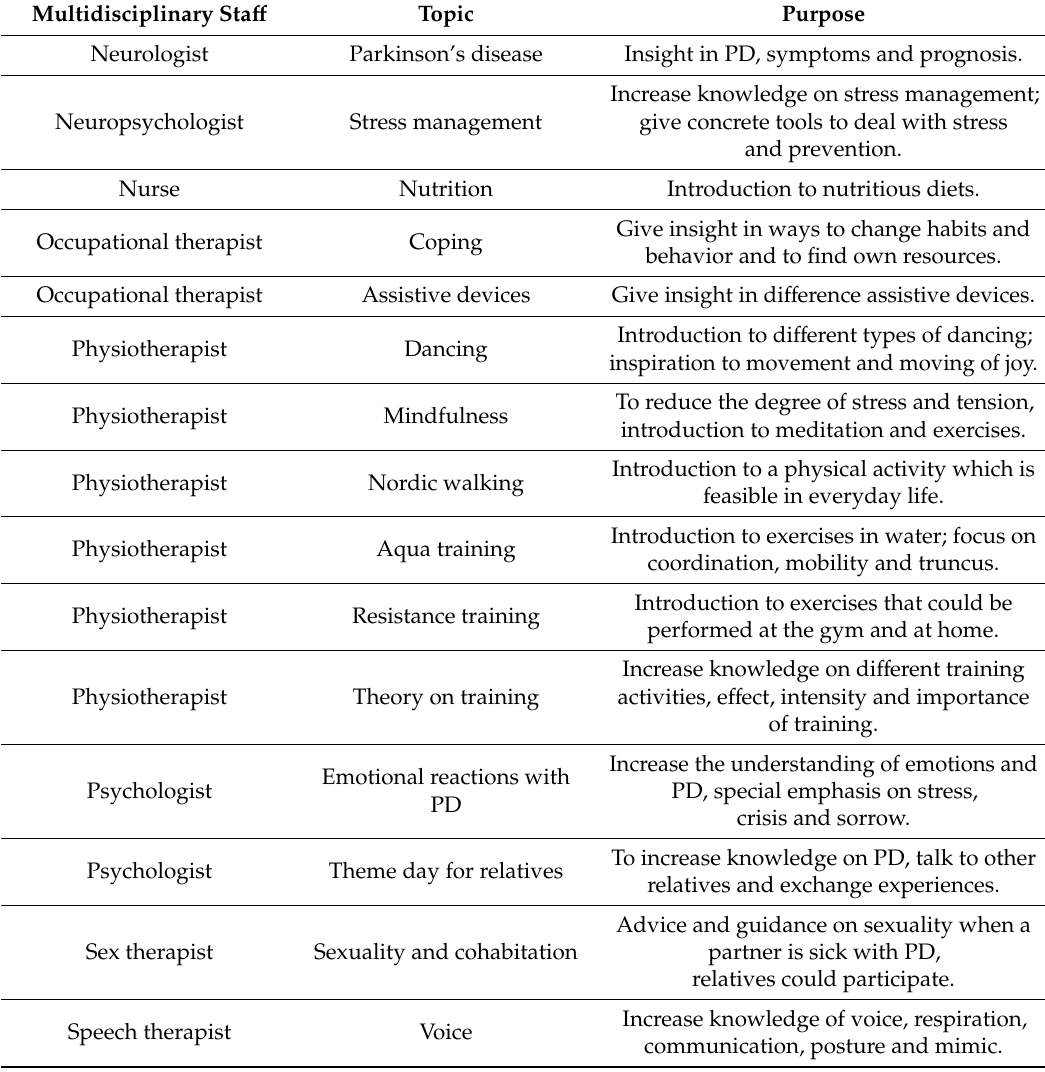
Table 2. Presentation of topics during the 2-week multidisciplinary rehabilitation